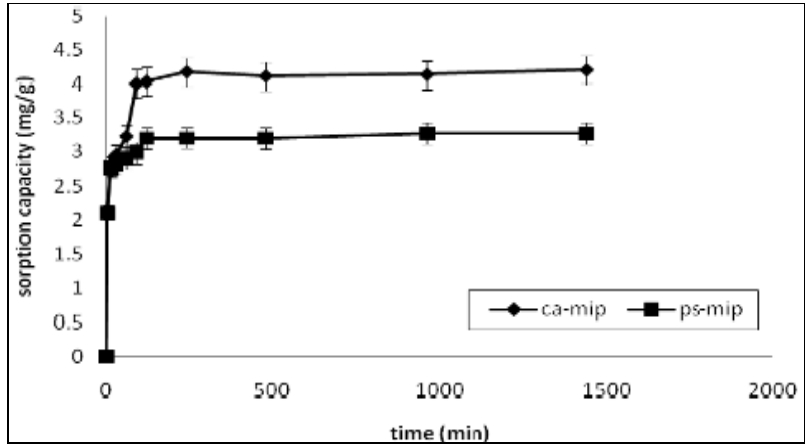
Figure 6. Sorption rates of 2,4-DNP by CA-MIP and PS-MIP. The initial concentration of 2,4-DNP is 10 mg/L.